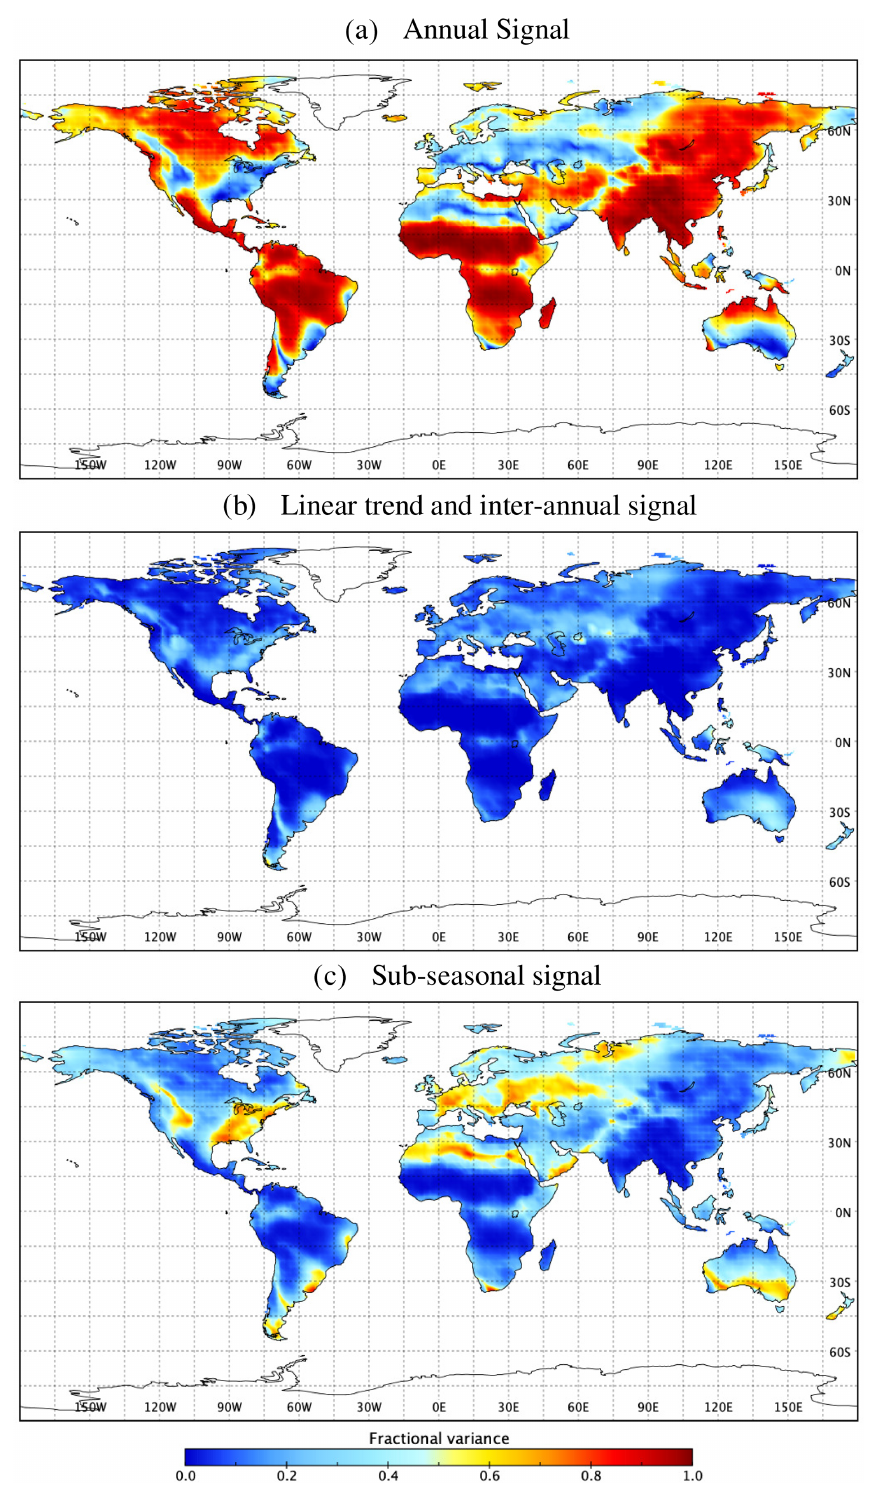
Figure 4. Fractional variance in the decomposed signal to the full signal. (a) Annual signal, (b) long-term signal and (c) sub-seasonal high-frequency